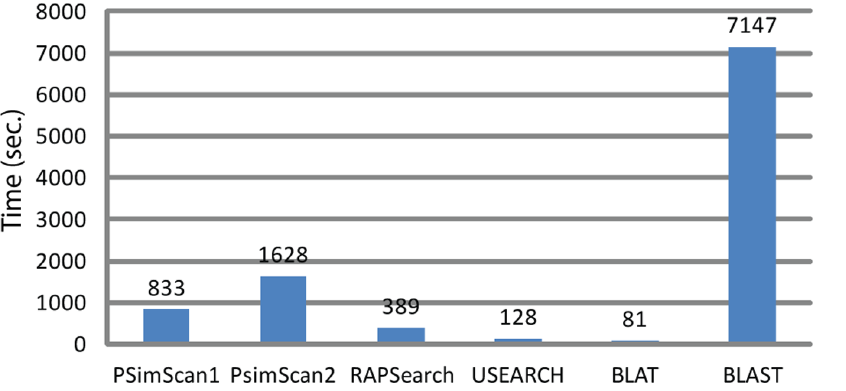
Figure 7. Processing speed for different quick protein similarity search tools. All measurements were taken at default parameters but for the ‘‘PSimScan2’’ series ( approx : 0.79, kthresh : 14). Streptococcus pneumoniae R6 proteome was used as the query set, SwissProt/UniProt database – as the subject set.